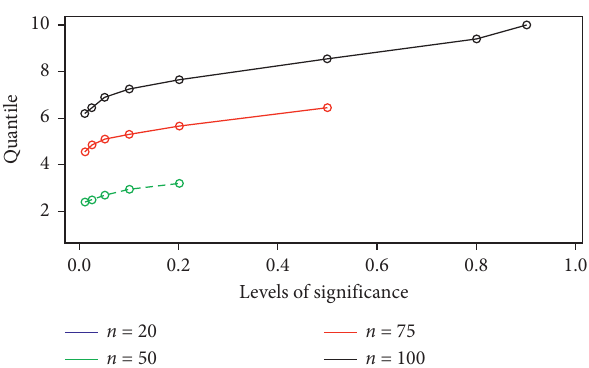
Figure 1: Simulation plot quantile at k � 4 with parameters (0.8, 0.05, 0.11, 0.99, 0.17, 2.0,